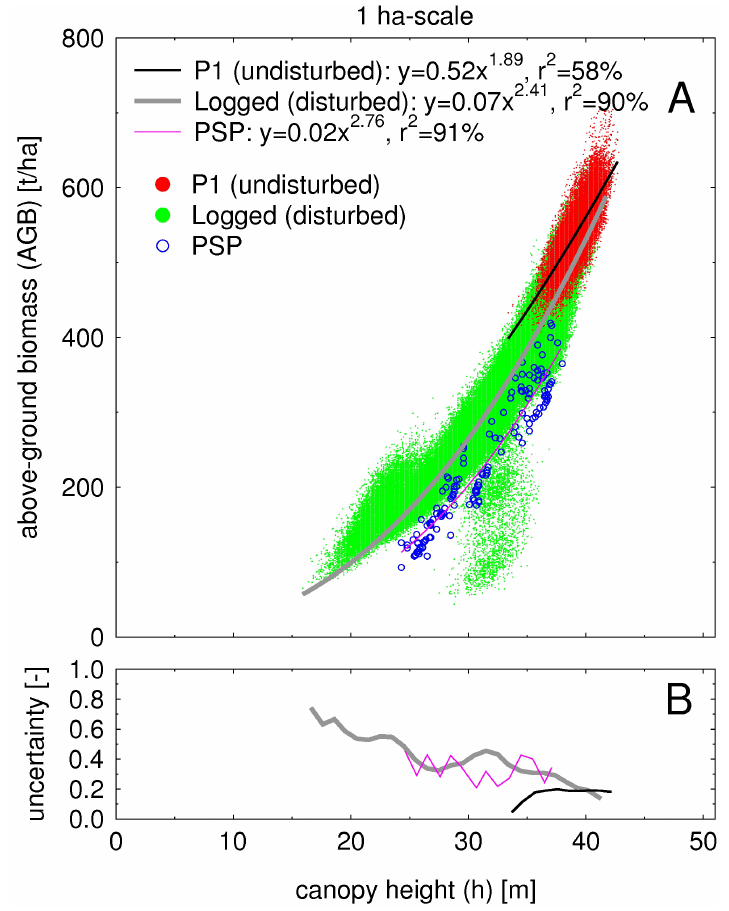
Fig. 5. (A) Above-ground life biomass (AGB) and canopy height ( h ) in 1ha-scale composition for the undisturbed site P1 (red), for disturbed forests in all 24 logging scenarios) (green), and for permanent sampling plot data (PSP, blue). (B) Relative uncertainty on the 95% confidence level (4 σ /mean), legend as in